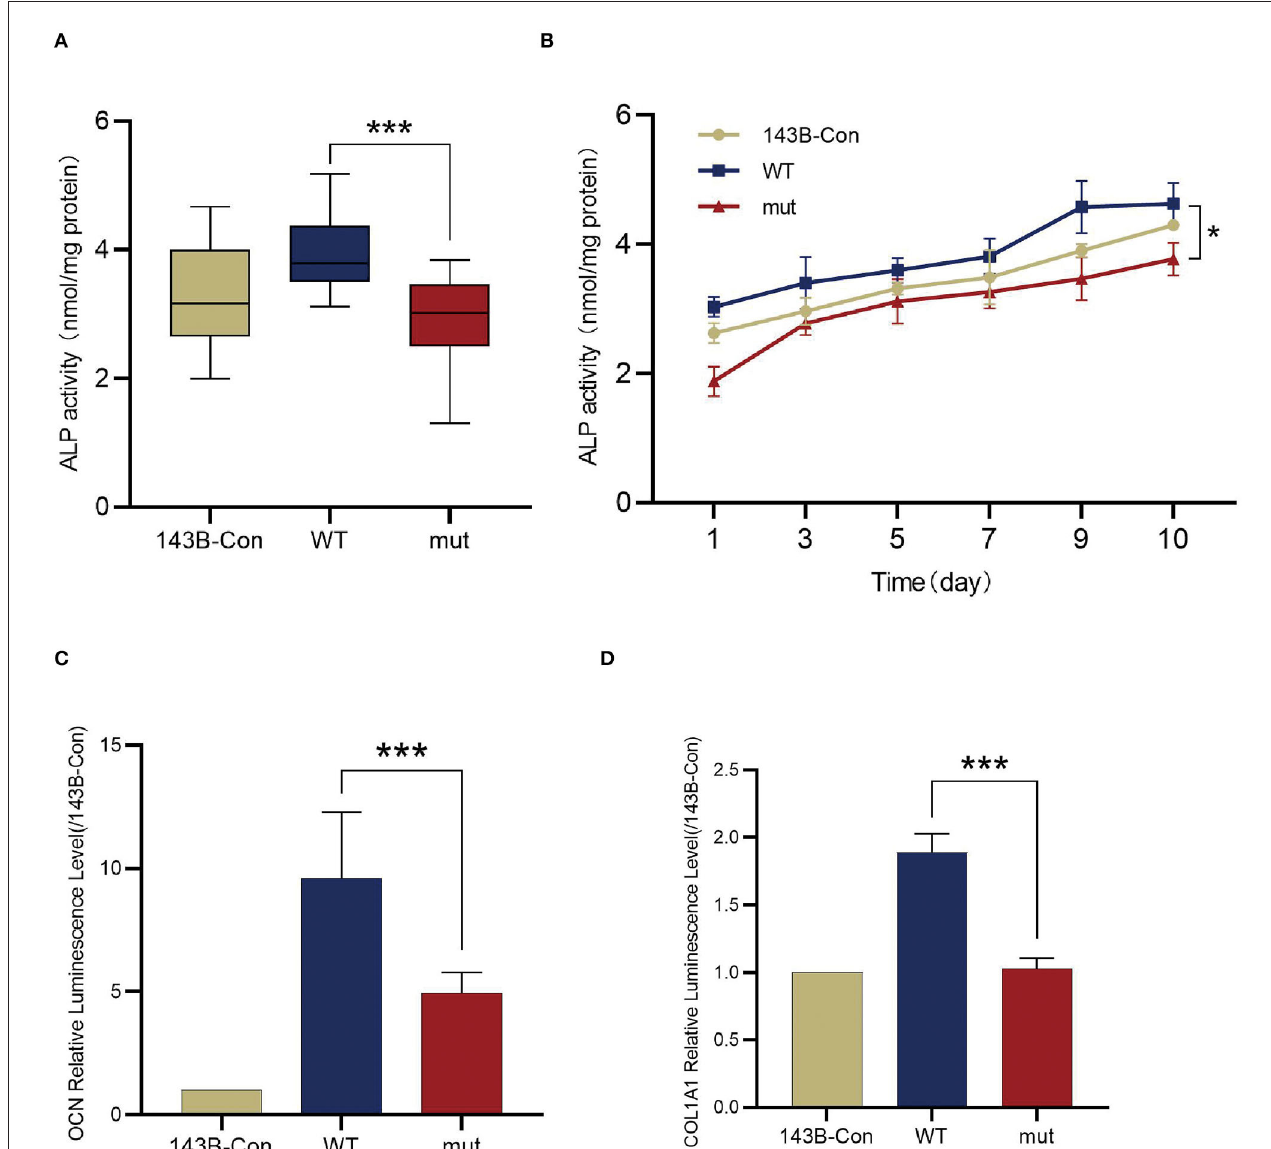
FIGURE 4 | Comparison of the osteogenic differentiations between wildtype 143B and mutant 143B. (A) ALP activity determined by ALP activity assay. (B) ALP activity was measured every other day for 10 days since stable cell lines cultured with osteogenic medium. (C) The transcription of OCN was evaluated by dual luciferase reporter gene assay. (D) The transcription of COL1A1 were evaluated by dual luciferase reporter gene assay. *** p < 0.001.